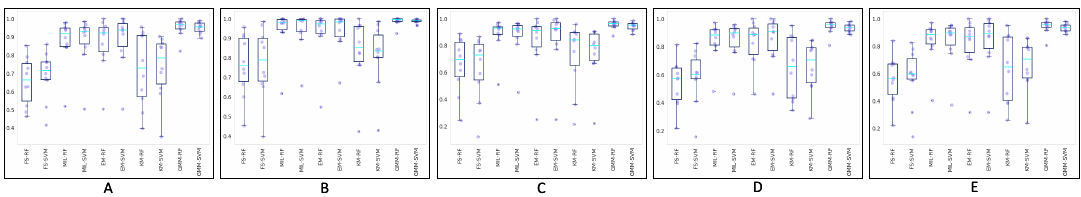
Figure 6. Boxplots of the 10-fold cross-validation results for weighted ( A ) accuracy, ( B ) area under the ROC curve (AUC), ( C ) precision, ( D ) recall, and ( E ) F1 score in different